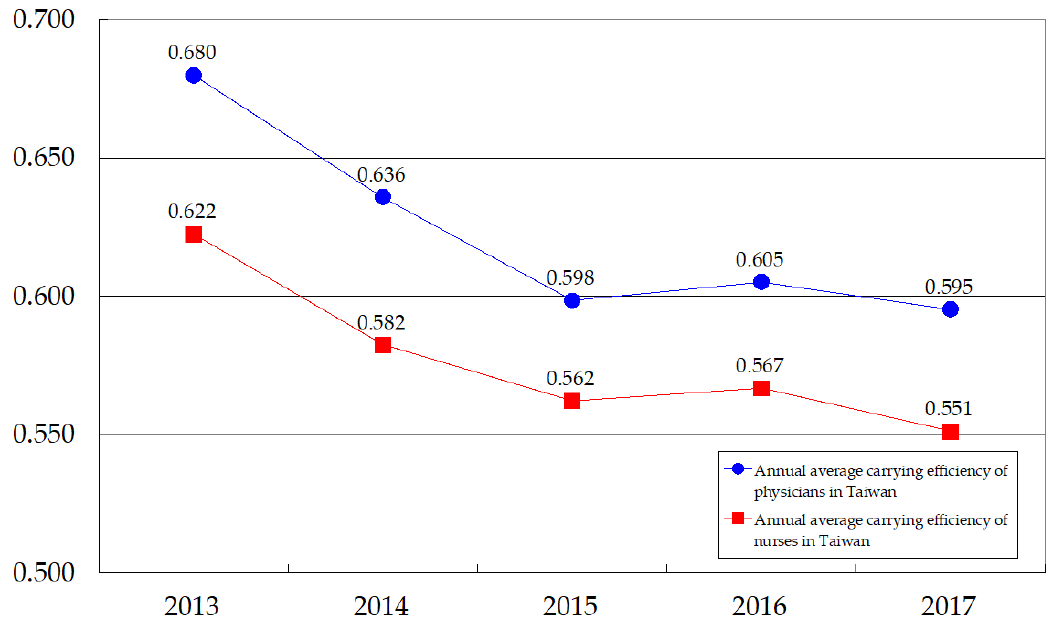
ffi ciency of medical sta ff in